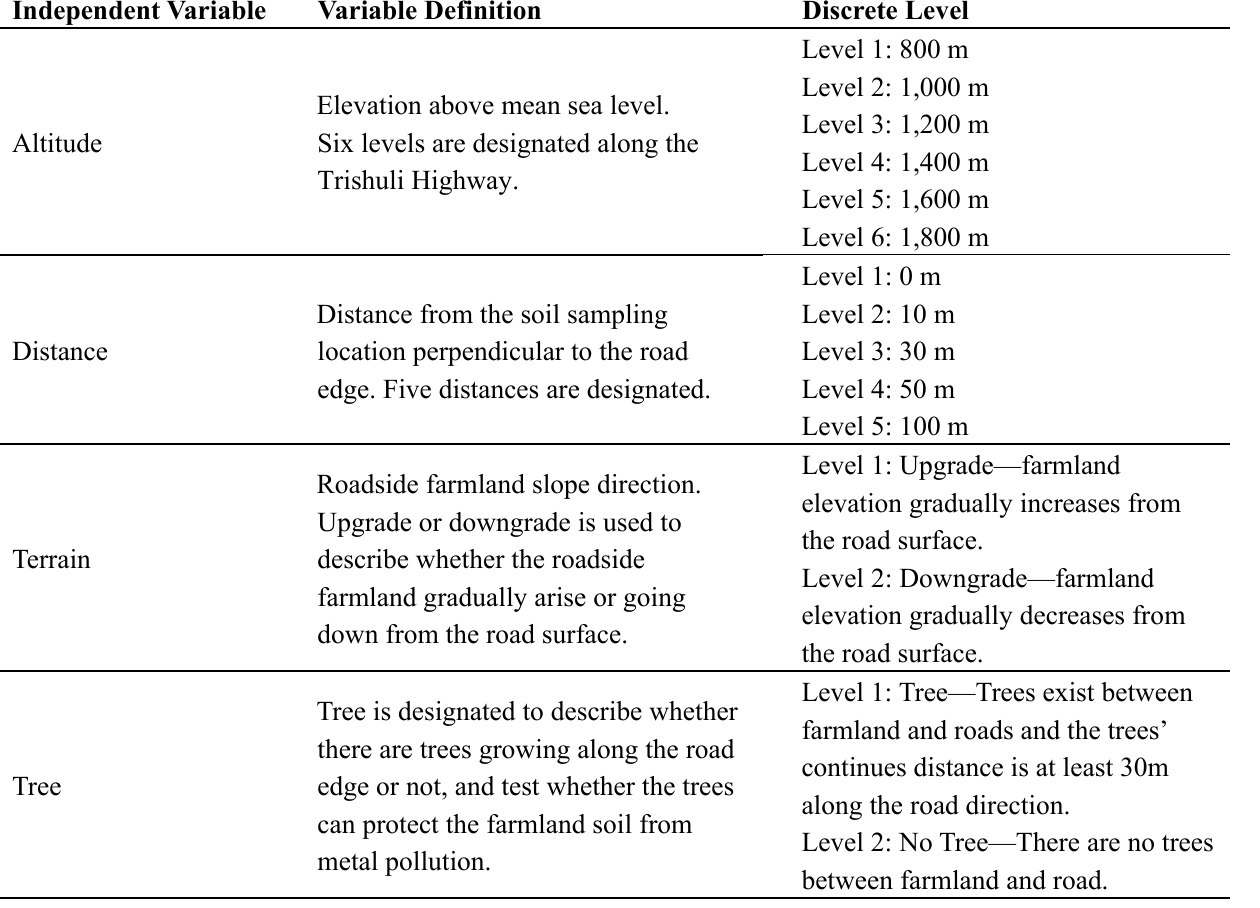
Table 1. Description of four independent variables for MANOVA